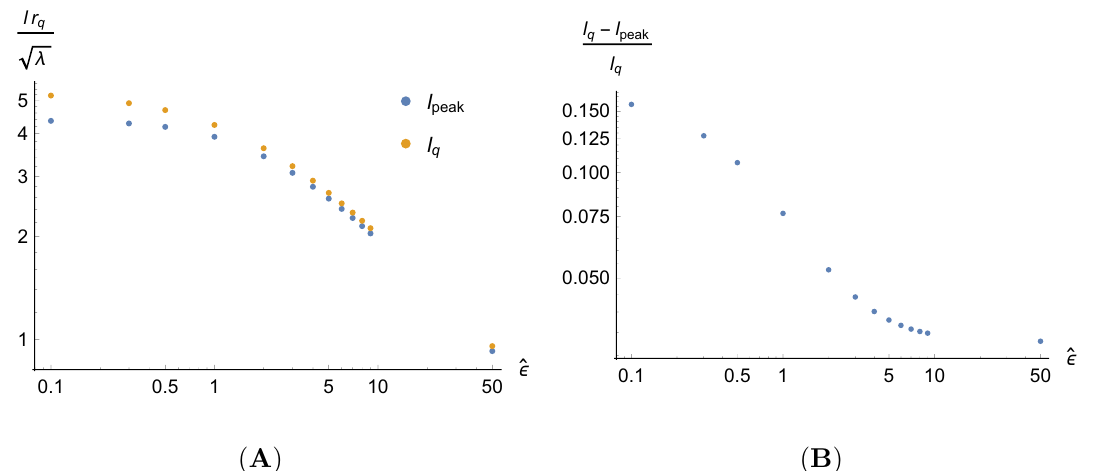
Figure 6 . Numerical analysis of the scale l peak at which the critical value of s=l maximally deviates from the conformal value. ( A ) Comparison of l peak r q = of (cid:13)avors (^ (cid:15) = (3 = 4)( N f =N ) (cid:21) ). Here l q is the strip width at which the corresponding bulk